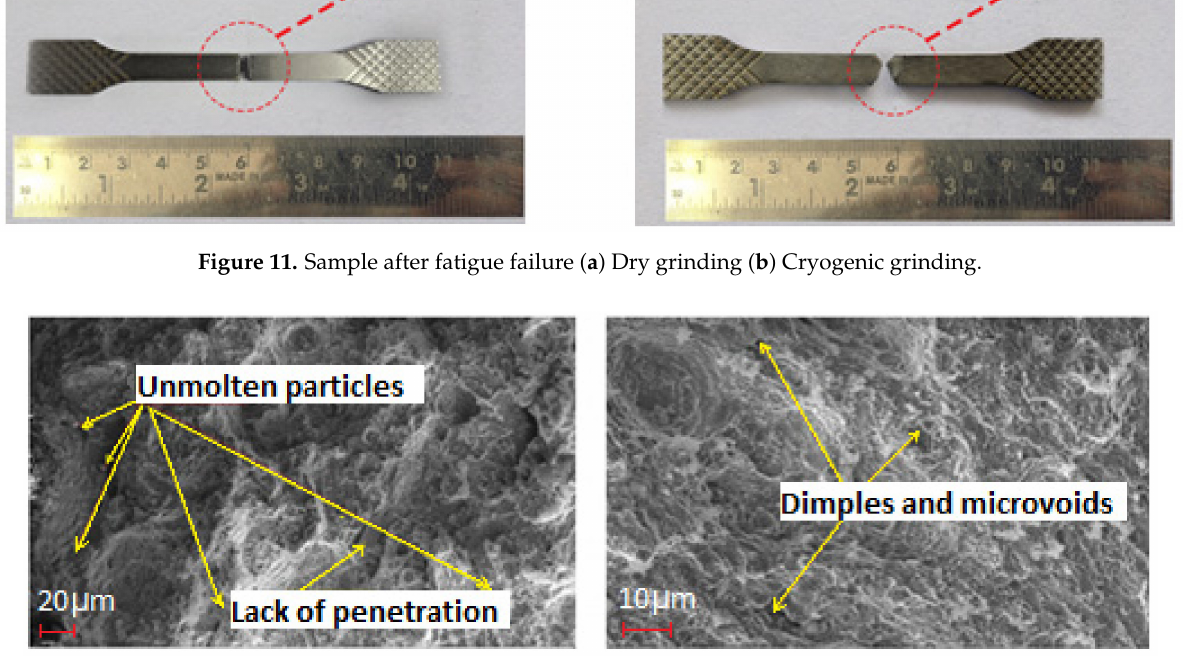
Figure 12. Fractographic analysis of